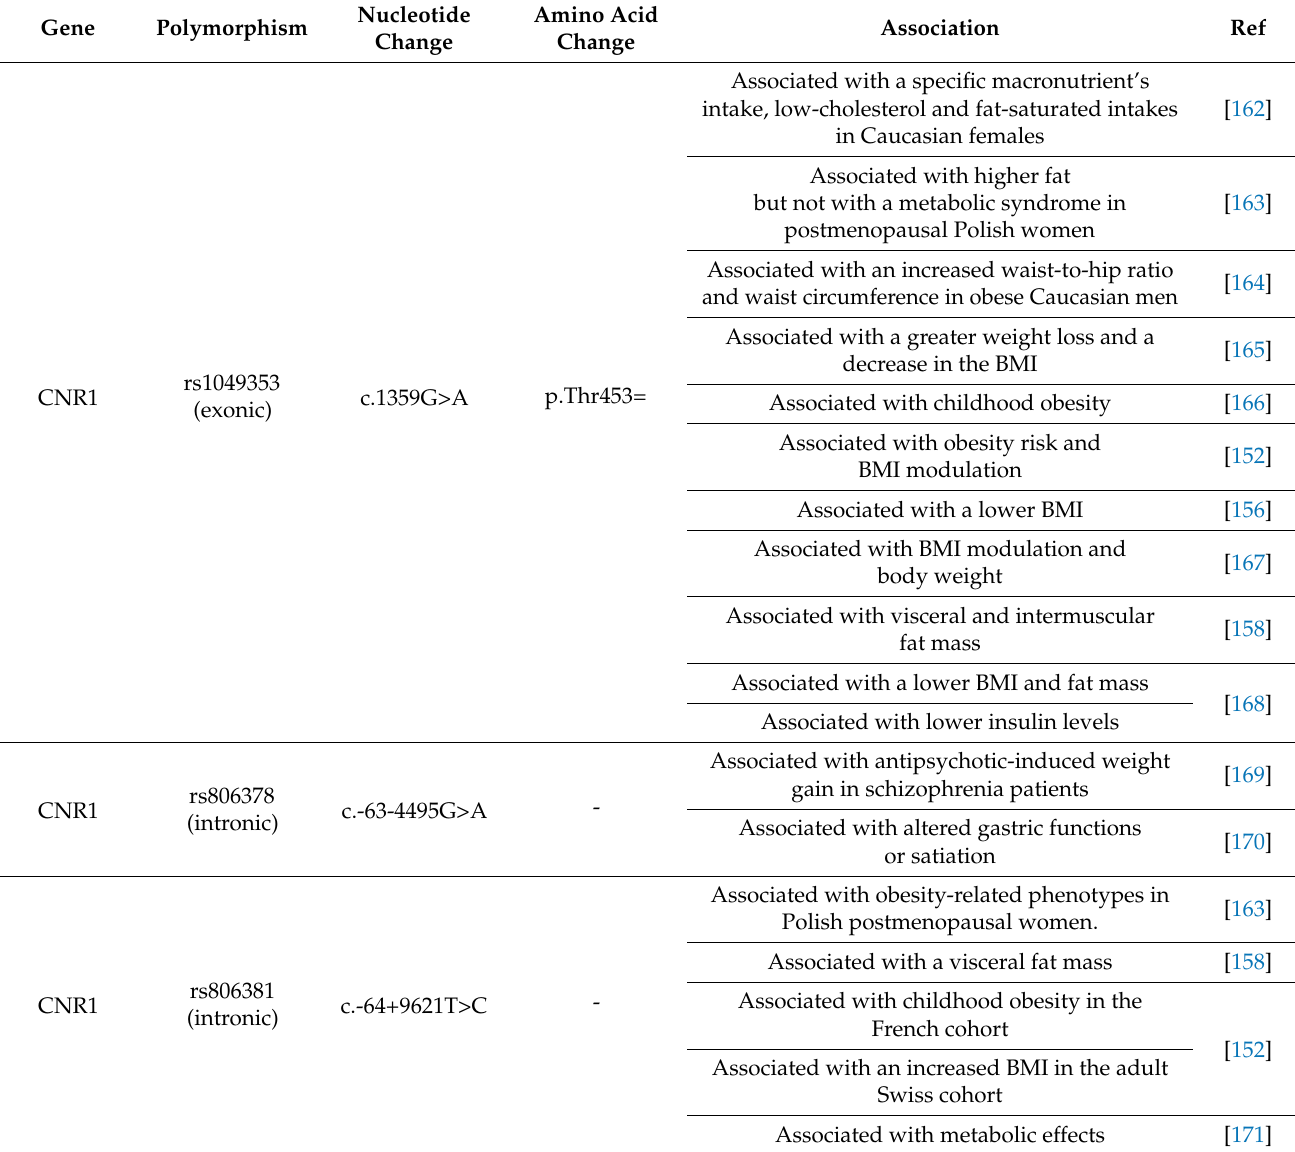
Table 2. Associations found between a single-nucleotide polymorphism in ECS obesity-related genes.